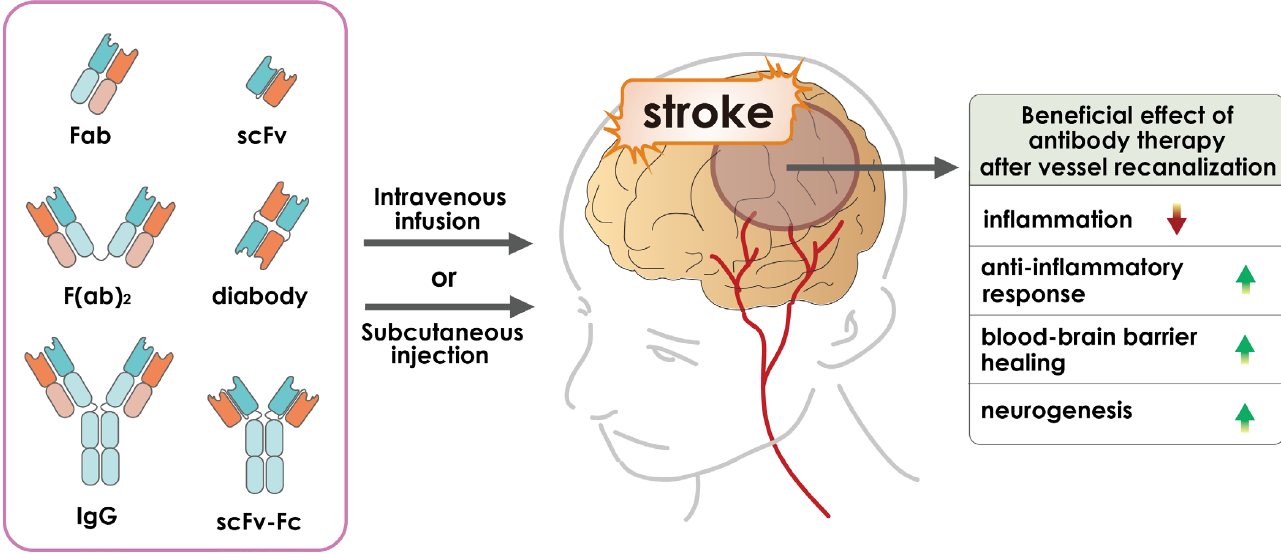
Figure 1. Schematic representative diagram demonstrating intravenous or subcutaneous injection of different forms of antibody-based medications to a stroke patient. The development of stroke triggers several mechanisms, including activation of glutamate receptors, which leads to the release